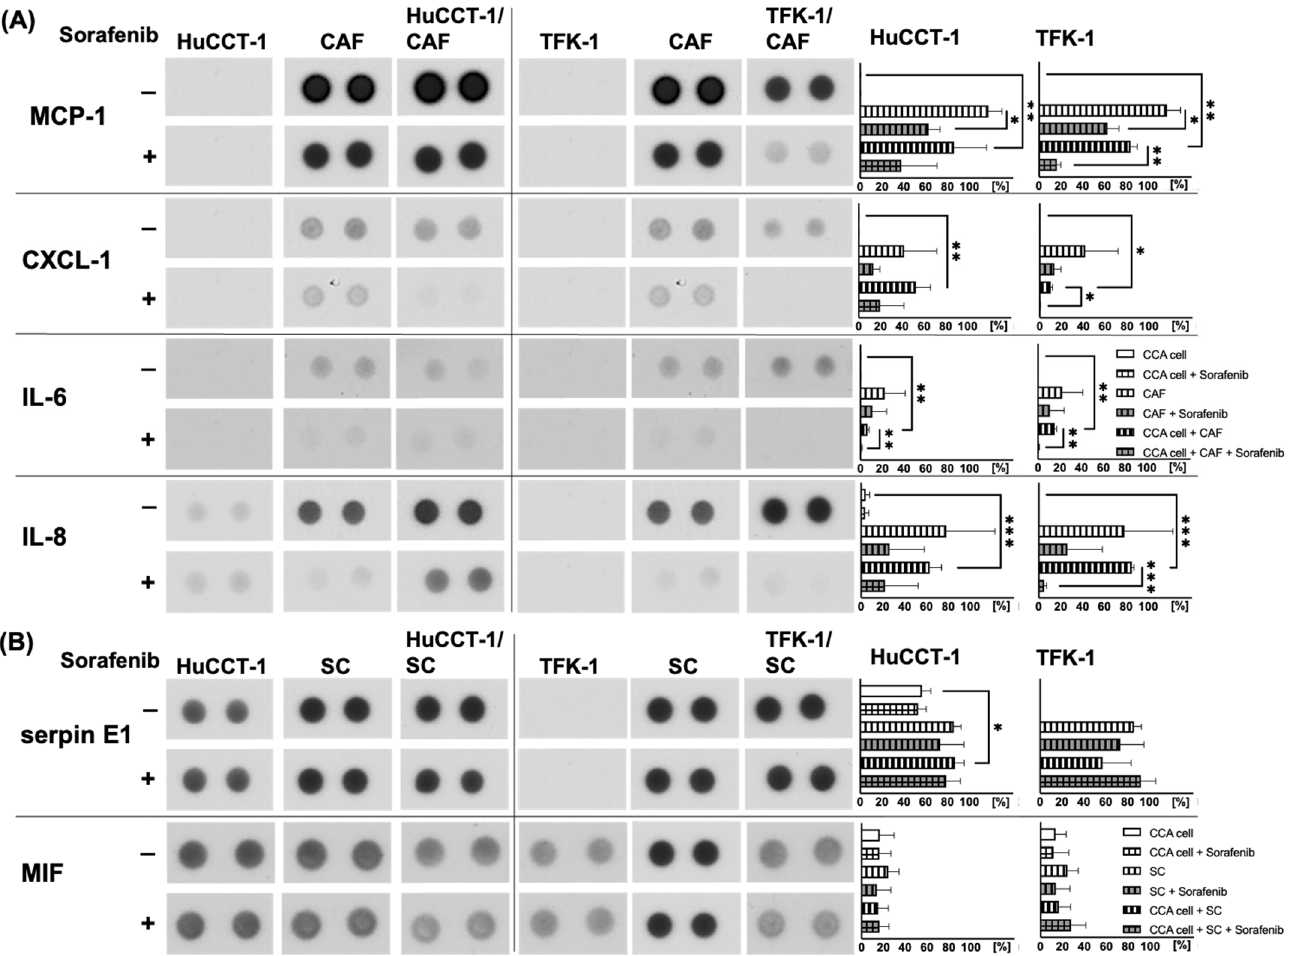
Figure 4. Detection of human cytokines and chemokines in supernatants of mono- and co-cultured CCA and stromal cells. HuCCT-1 and TFK-1 cells were cultured either alone or together with CAF or SC in transwell systems. Mono-cultured CAF and SC were cultured in parallel as control. Additionally, cells were either left untreated or treated with 1 µM Sorafenib for 72 h. Cell culture supernatants were analyzed using the Proteome Profiler Human Cytokine Array Kit, Panel A. Shown are representative results of mono- and co-cultures of CCA cells with ( A ) CAF and ( B ) SC. Pictures are taken from one experiment out of three independent biological replicates. Right to each blot, mean spot densitometries of all replicates ± standard deviation are shown. Significances were defined using asterisks: * p < 0.05, ** p < 0.01, *** p < 0.001.